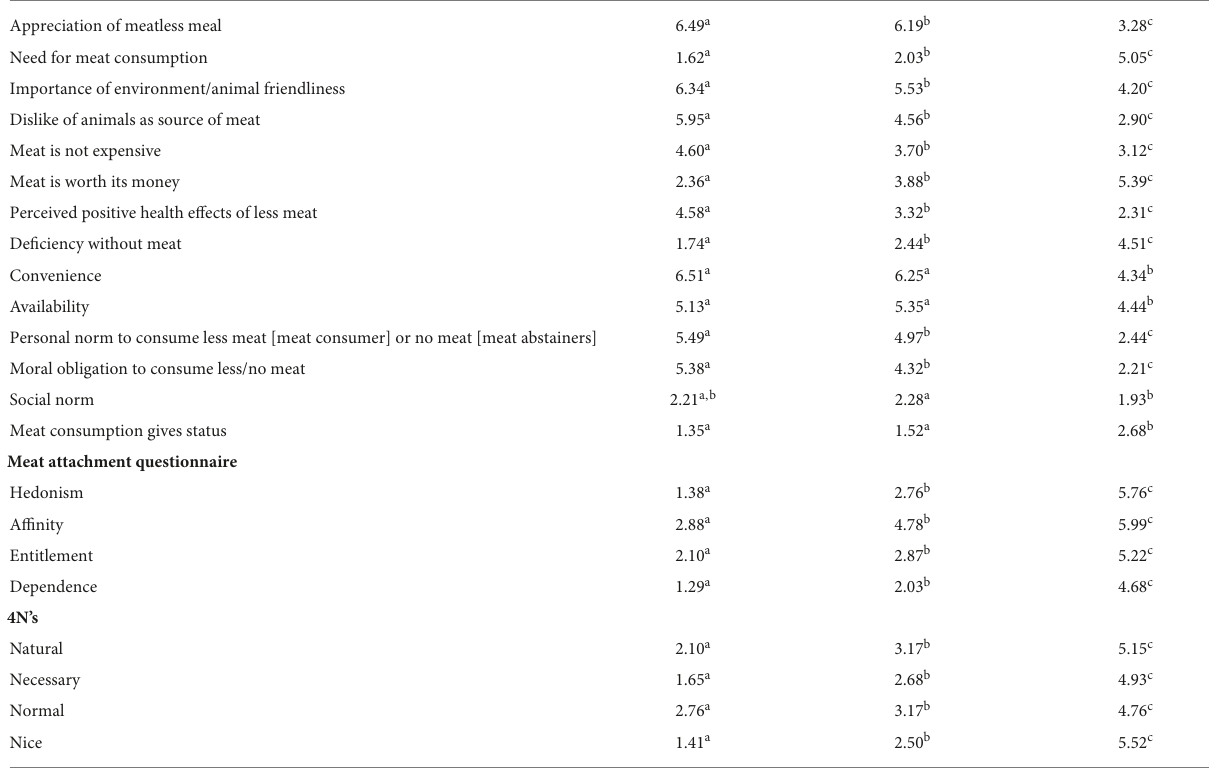
TABLE 2 Mean scores on meat-related attitudes and norms per dietary consumer group. Meat abstainers Committed meat reducers Avid meat